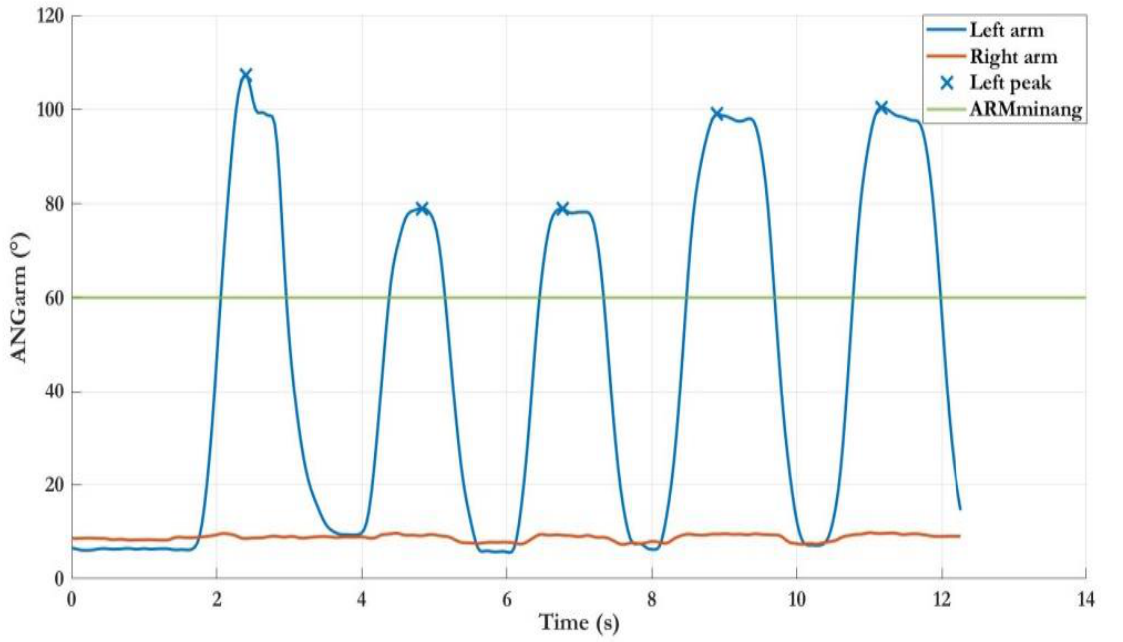
Figure 4. Example of the trajectories of left and right arm angles during the first subtask of the Lateral Weightlifting exergame (left arm movements). Correctly, no movement was detected in the right arm. All movements performed with the left arm were considered good movements (blue crosses).